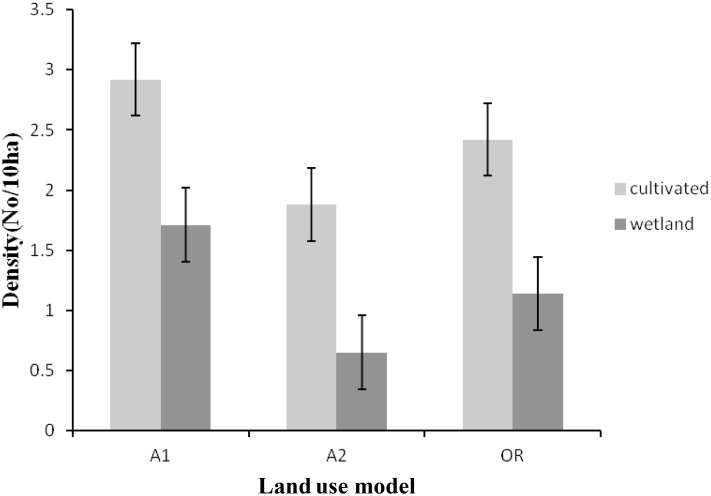
Densities of the Grey Crowned Crane for each land-use category in 2012.Where A1 = the self contained small scale commercial farms of 30 to 40 ha per household, A2 = large scale commercial agriculture farms of > 50 ha per household and OR = Old Resettlement, villagized agriculture farms of < 5 ha per household with communal grazing land. Error bars indicate level of error margin (±0.05) or uncertainty of population densities recorded in this study.